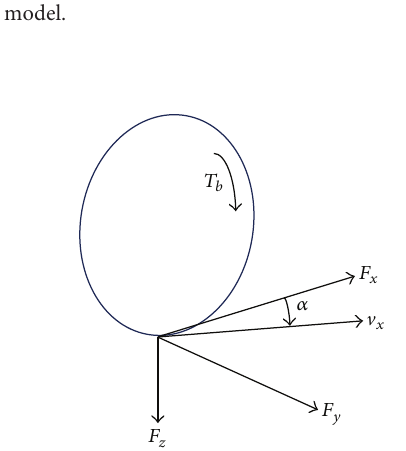
Figure 1: Simplified bicycle model.